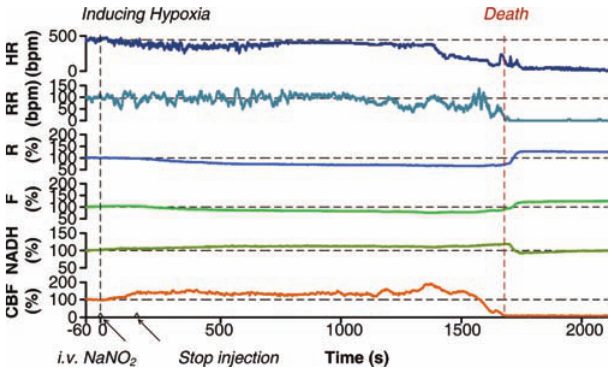
Fig. 2. Typical demonstrations of multiparametric monitoring during the procedure of hypemic hypoxia. The rat was iv injected 100 mg/kg sodium nitrate at the time point